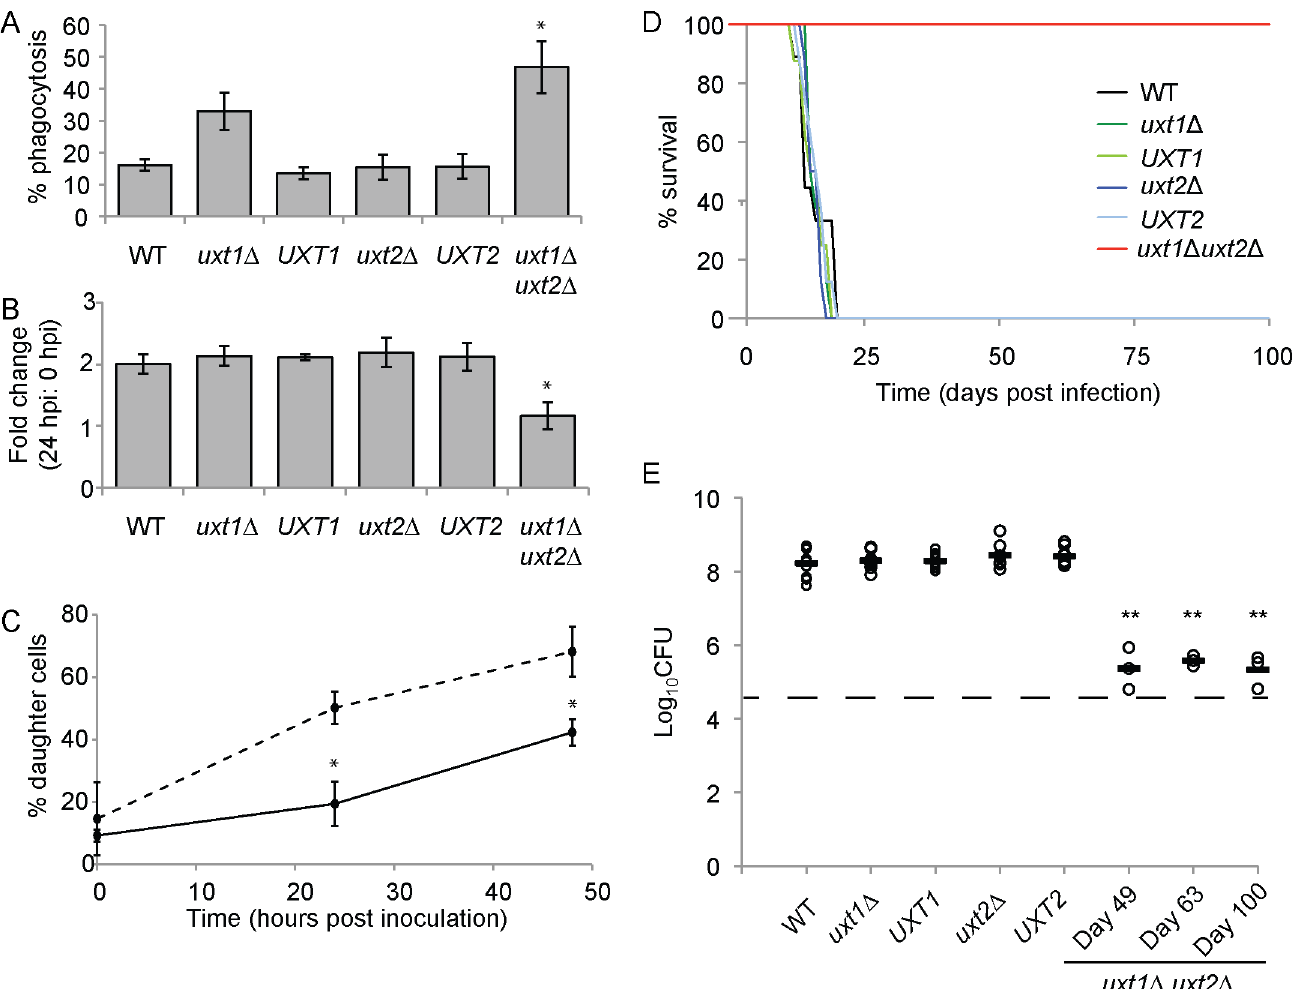
Fig 6. UDP-Xyl transport is required for host interactions and virulence. (A) Percent phagocytosis(engulfedfungi/initialinoculum)of opsonized fungi. (B) Fold-change in colony-forming units (CFU) 24 h:0 h after internalization. (C) Proportionof daughter cells in the population of WT (dashedline) and uxt1 Δ uxt2 Δ (black line) cells incubatedwith BMMs for 0, 24, and 48 h. Data are the mean ± SEM of three independentexperiments. * , p < 0.05 by (A, B) one-wayANOVA with Tukey’s post hoc test or (C) Student t-test. (D) Survival of A/JCr mice after intranasal inoculation with 5 × 10 4 cells of the indicatedstrains (n = 8–9). (E) LungCFU of infected mice at the time of death (for WT, uxt1 Δ , uxt2 Δ , and complemented mutants; n = 8) or at the indicatedtime points (for uxt1 Δ uxt2 Δ ; n = 3). Open circles, individual mice; black bar, mean; dashed line, initial inoculum. ** , p < 0.01 by one-way ANOVA with Tukey’s post hoc